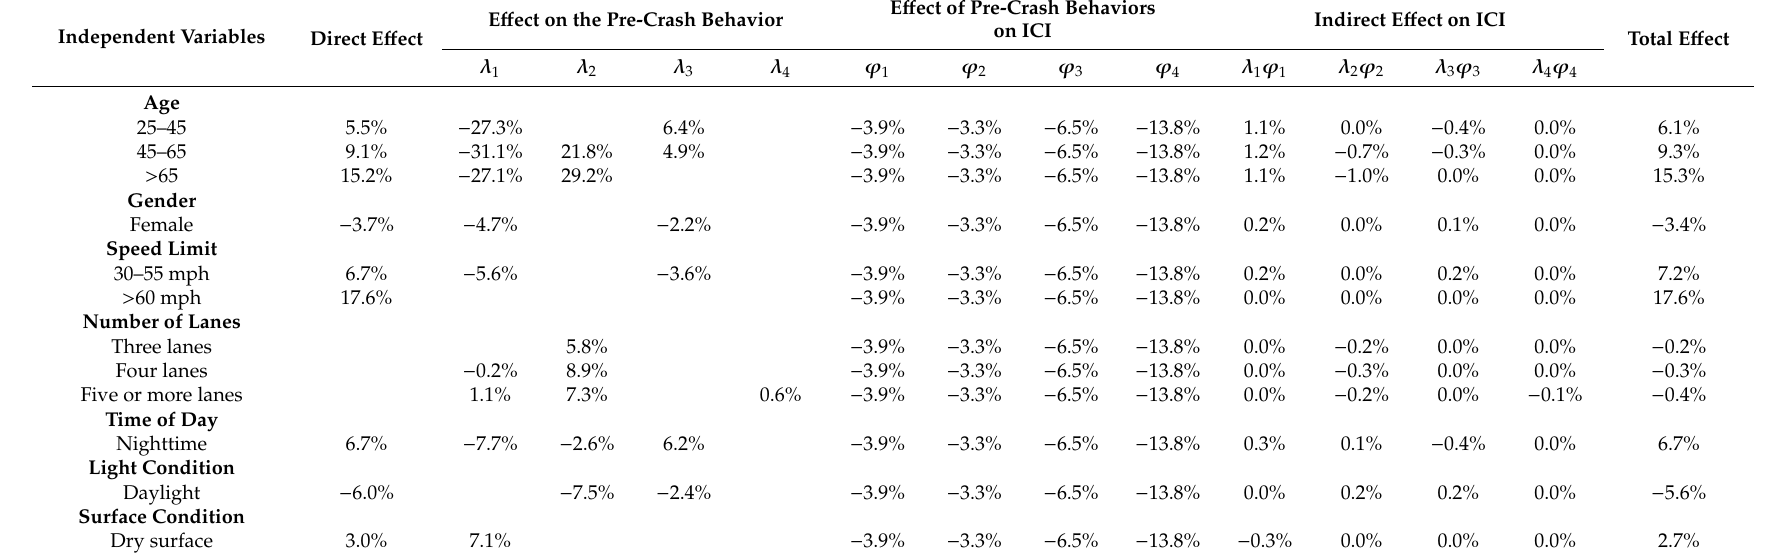
Table 4. Direct, indirect, and total e ff ects of variables on the Incapacitating injury